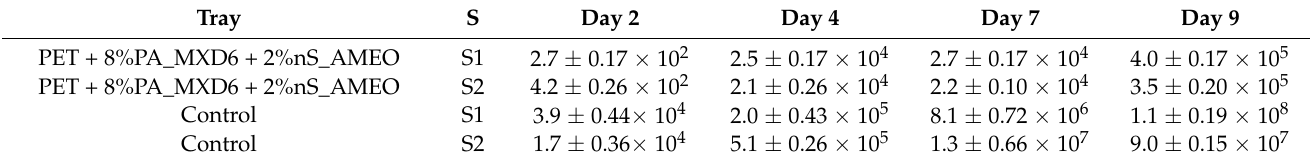
Table 8. Mesophilic anaerobes count (ufc/g) in sliced sea bam packed in